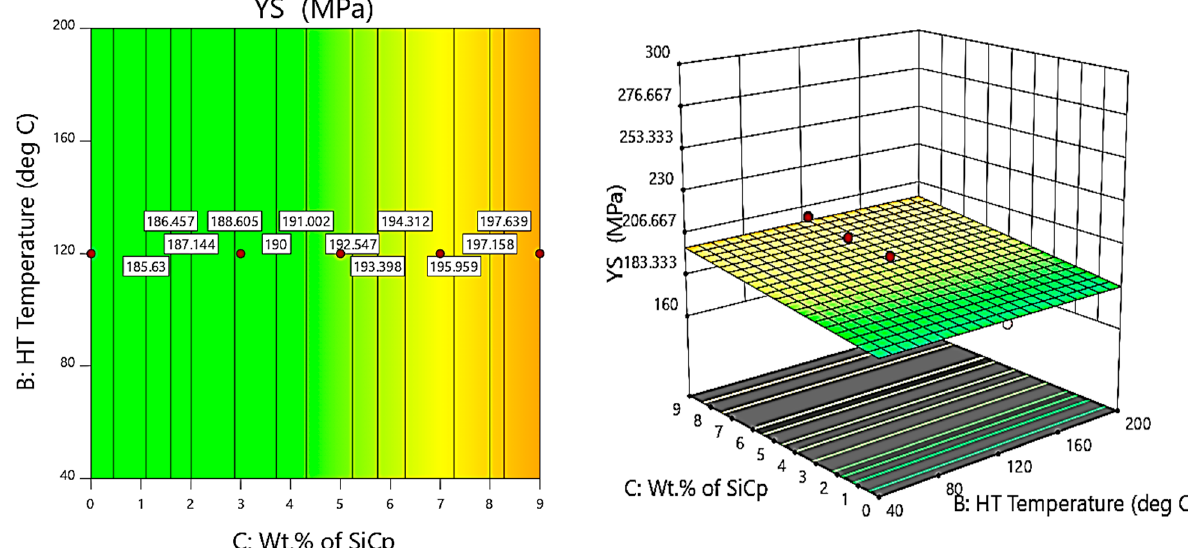
Figure 15. Contour and 3D Surface plots for variation of YS with varying wt.% of SiC and HT temperature.